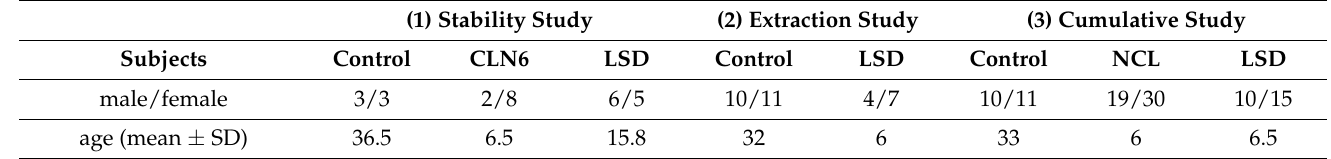
Table 2. Distribution of the individuals by